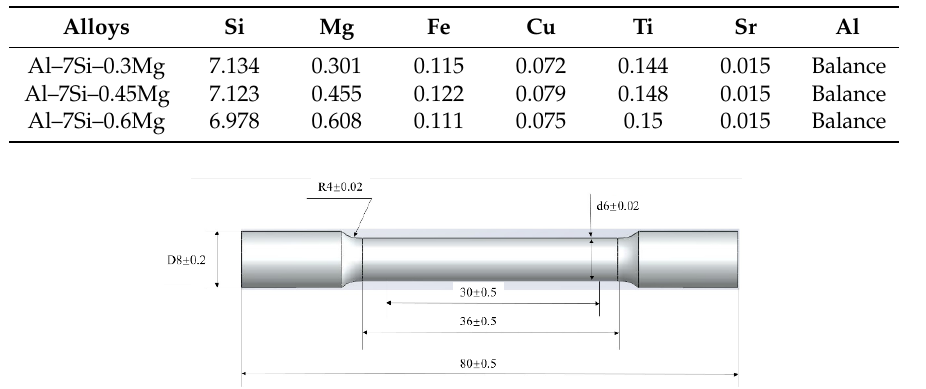
Table 1. Chemical composition of the tested alloys (wt.%).